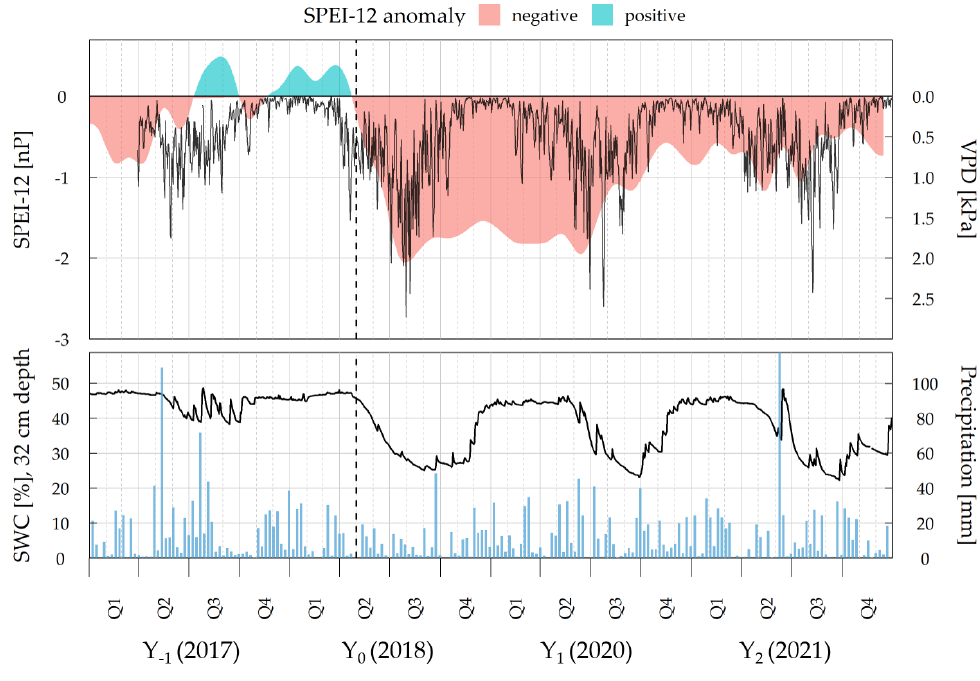
Figure 1. Drought-related meteorological variables. Top : standardized precipitation evapotranspira- tion index (SPEI-12) [51] and vapor pressure deficit (VPD) [52]. SPEI was calculated on the basis of potential evapotranspiration and precipitation from HNP eddy covariance flux tower data [50] and was integrated for 12 month-periods with an unshifted rectangular kernel. Bottom : soil water content (SWC) and precipitation. The onset of the drought is indicated as a dashed vertical line. Precipitation data are weekly sums, while others are daily means. The meteorological data were retrieved from the flux tower at 44 m above ground, except for SWC (8 cm soil